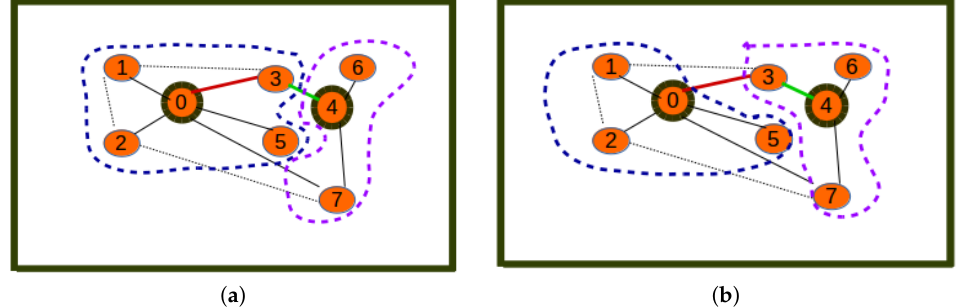
Figure 7. Relaxation: energy inefficiency. ( a ) Inefficient clustering; ( b ) efficient